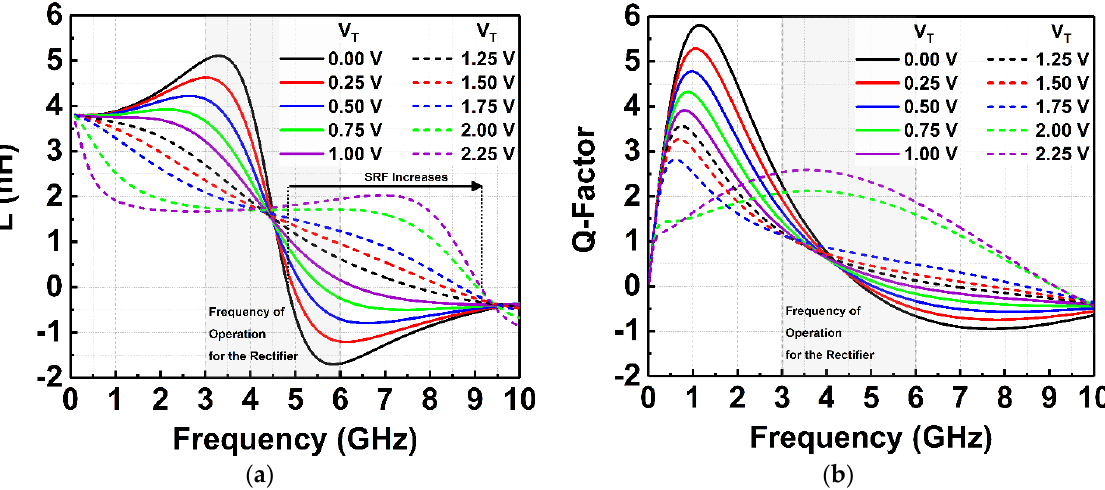
Figure 11. ( a ) Simulated inductance values of the TVB when V T is tuned. ( b ) Simulated Q-factor values of the TVB when V T is